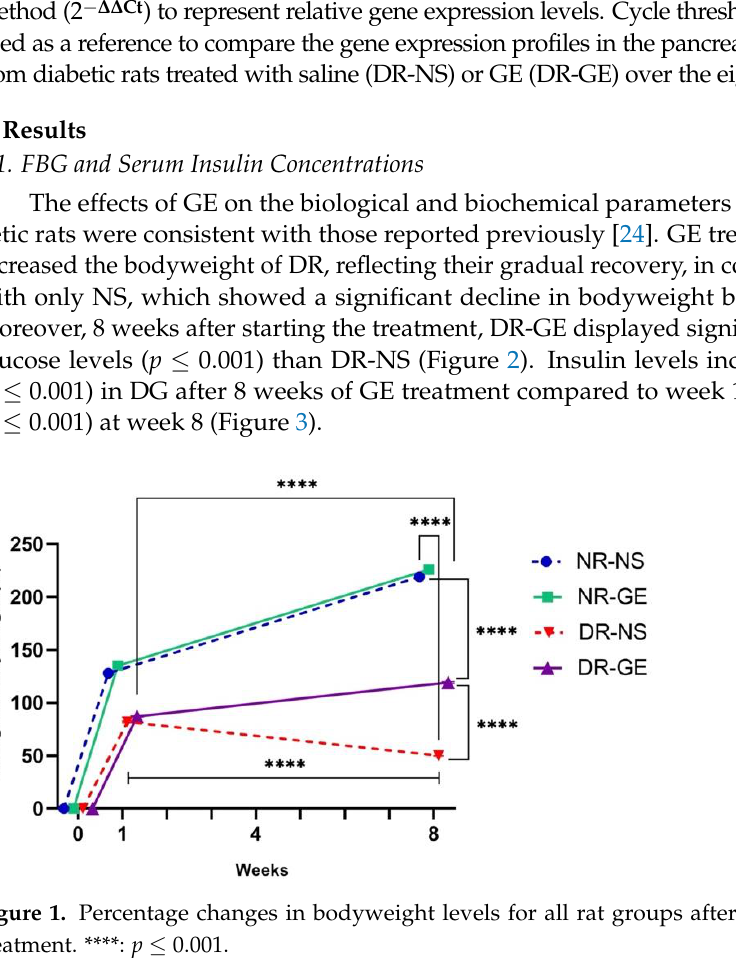
Figure 2. Changes in fasting blood glucose (mmol/L) for all rat groups after 1 and 8 weeks of GE treatment. *: p ≤ 0.05, ***: p ≤ 0.01, ****: p ≤ 0.001. Figure 3. Changes in serum insulin levels (ng/mL) for all rat groups after 1 and 8 weeks of GE treat- ment. ns: no significance, ****: p ≤ 0.001.